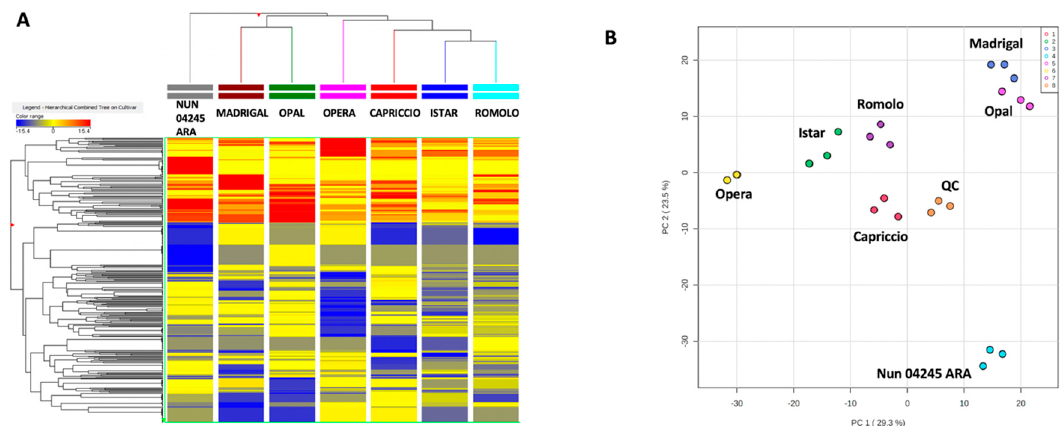
Figure 2. Heat map from unsupervised hierarchical cluster analysis ( A ) and principal component analysis (PCA) score plot ( B ) built considering the phytochemical profile of the different artichoke cultivars. In the PCA score plot, the distribution of Quality Control (QC) sample replicates is also showed.